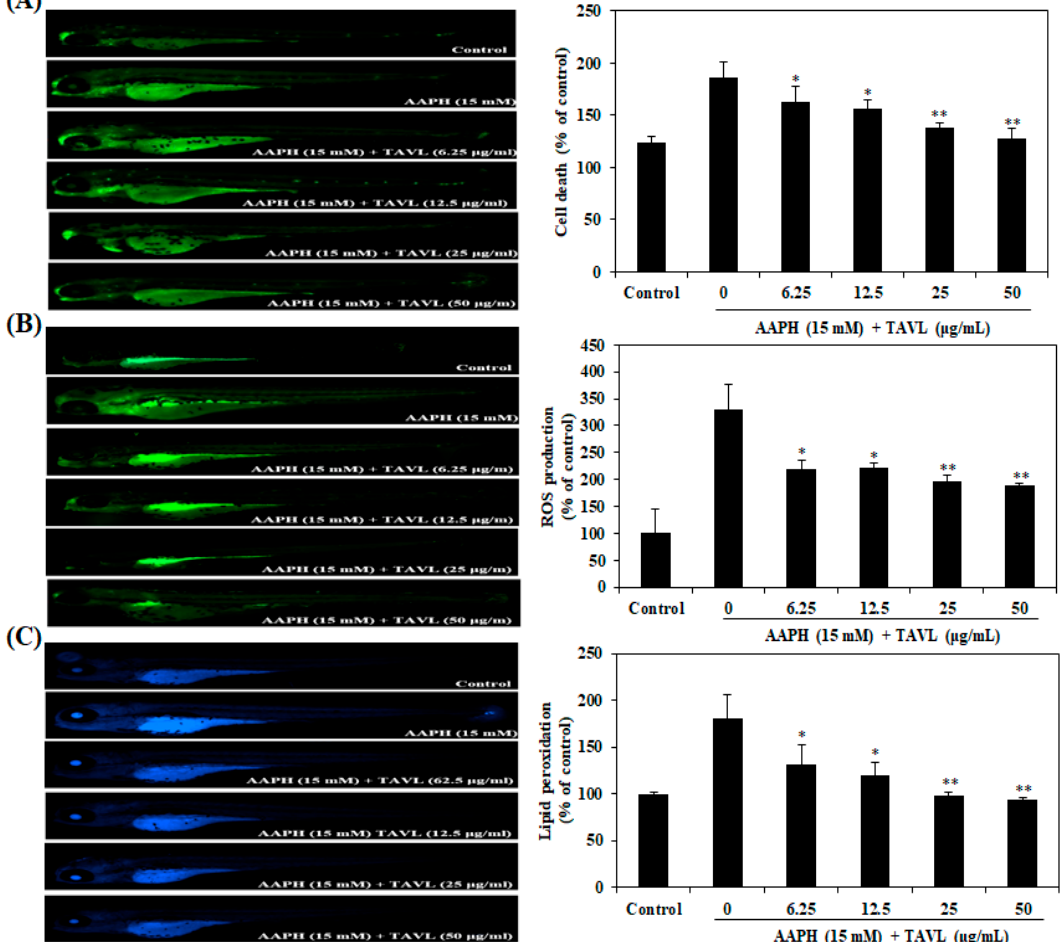
Figure 3. Protective effects of antioxidant peptide (TAVL) against AAPH-induced oxidative stress in zebrafish model. ( A ) Protective effect of TAVL on AAPH-induced cell death in zebrafish embryos. Cell death levels were measured after staining with acridine orange followed by image analysis and fluorescence microscopy. ( B ) Inhibitory effect of TAVL on AAPH-induced ROS production in